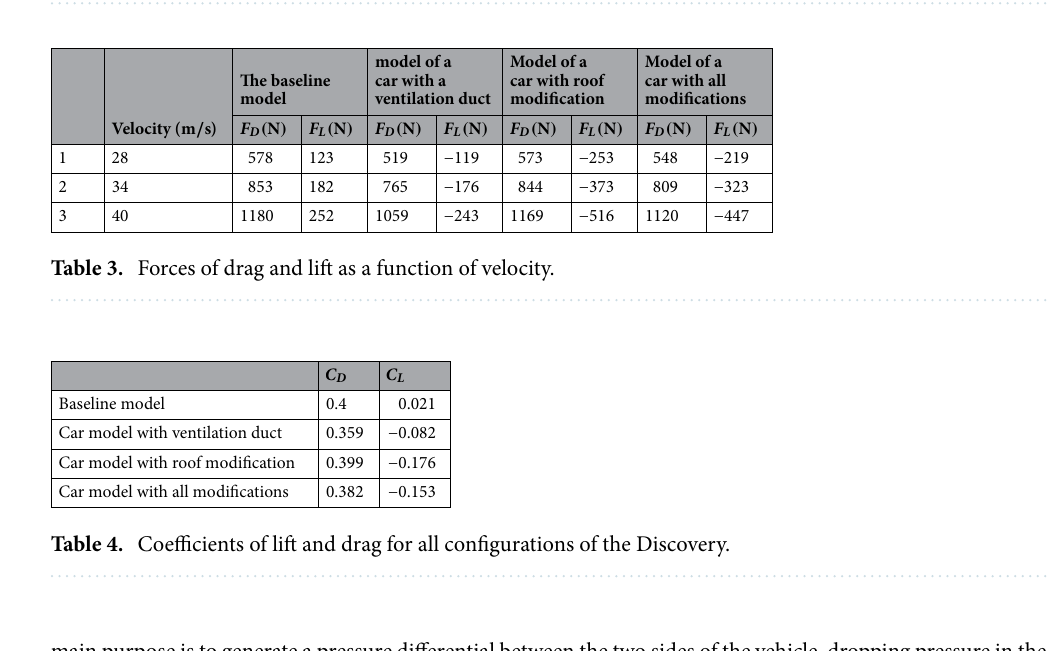
main purpose is to generate a pressure differential between the two sides of the vehicle, dropping pressure in the front and boosting it in the back, resulting in a reduced drag coefficient. The car’s roof modification puts more pressure above the car, which improves the vehicle’s road stability, especially at high speeds. A combination of the ventilation duct and roof alteration gives better fuel usage efficiency and road safety, with C D of 0.382791 compared to the baseline model and C L of −0.153046 compared to the baseline model. Data availability All data generated or analysed during this study are included in this published article.